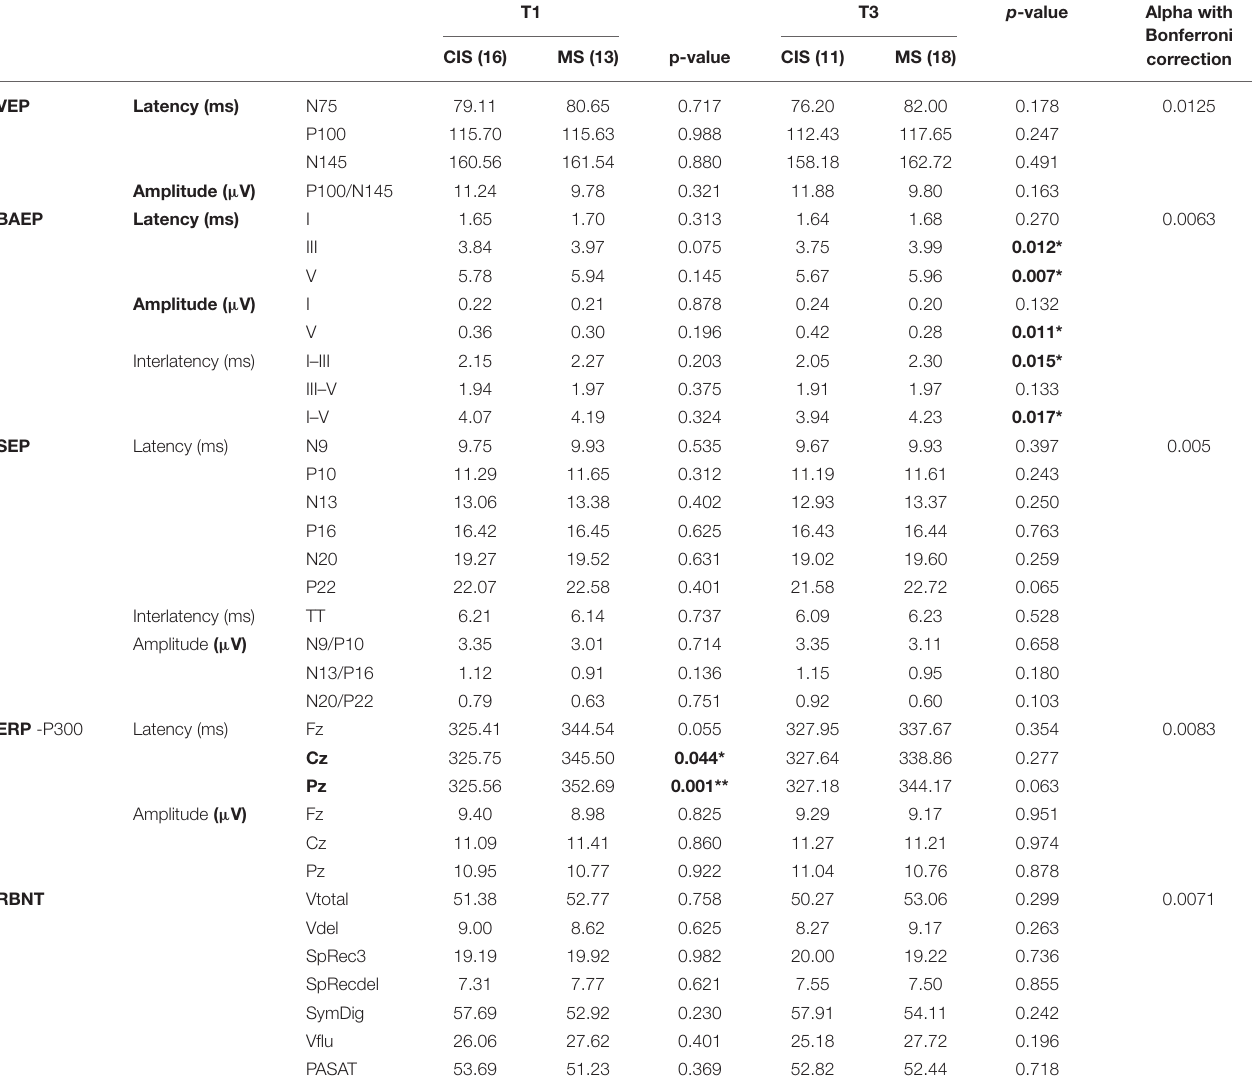
TABLE 5 | Analysis of EP and BRBNT baseline parameters in the study group with regard to diagnosis of MS evaluated at T1 and T3. T1 T3 p